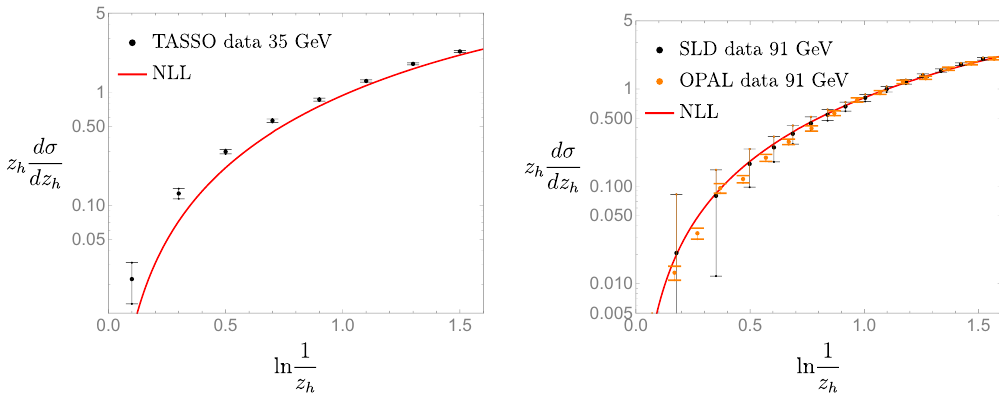
Figure 7 . The fragmentation spectrum extrapolated into the large z h region for e + e − → h ± + X at center of mass energies Q = 35 and 91 . The region below ln 1